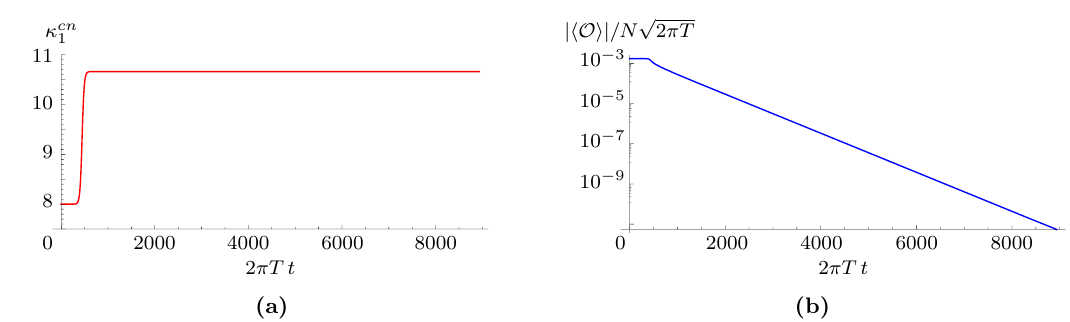
Figure 4. The quench pro(cid:12)le (left) and the time evolution of the absolute value of hOi (right) for a quench from the condensed to the normal phase. The quench parameters are (cid:20) i = 8, (cid:20) f (cid:25) 10 : 7, s (cid:25) 0 : 022 and 2 (cid:25)T t 0 (cid:25) 447.